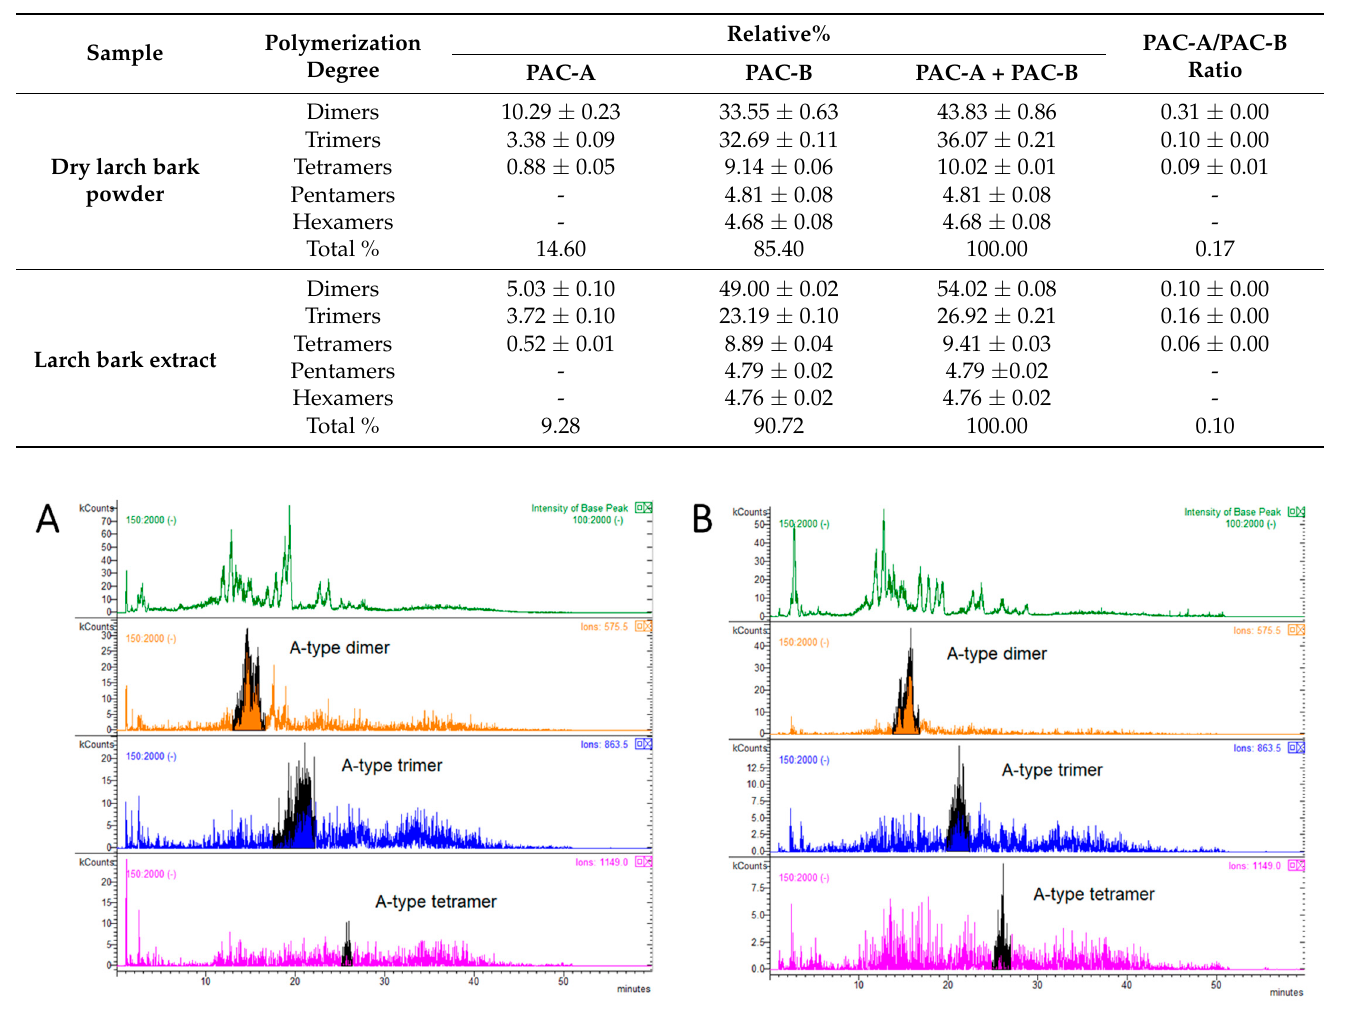
Table 2. Relative PAC-A and PAC-B % and PAC-A/PAC-B ratio related to polymerization degree of PACs contained in dry larch bark powder and in larch bark extract. Data were obtained by HPLC-MS analysis and are expressed as % w / w ± SD.